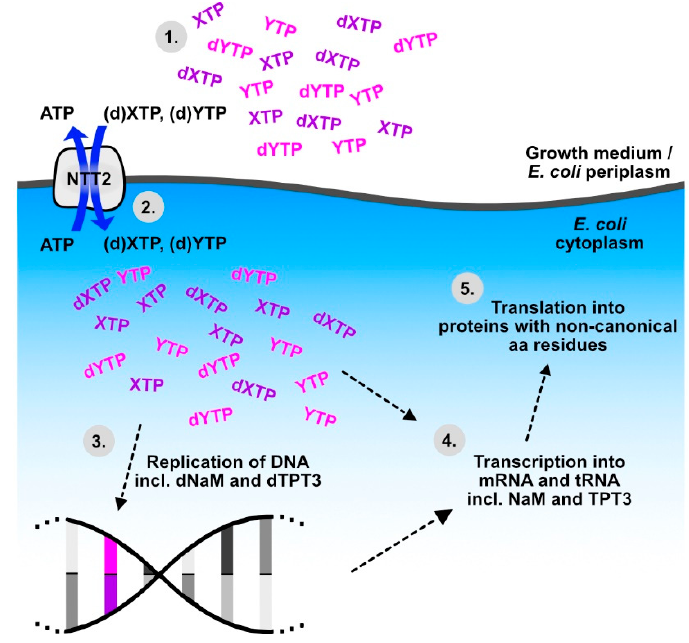
Figure 2. Pt NTT2 provides a crucial step to the workflow of expanding the genetic alphabet for the inclusion of non-canonical amino acids into proteins, as established by Zhang et al. [87]. (1) Artificial nucleotides (deoxy- and ribotriphosphates of NaM (dXTP, XTP) and TPT3 (dYTP, YTP)) are added to the surrounding medium. (2) The broad substrate specificity of Pt NTT2 allows for the uptake of (d)XTP and (d)YTP into Escherichia coli , in exchange for naturally occurring ATP. (3) DNA polymerase replicates templates that contain dNaM and dTPT3, leading to stable reproduction of the modified DNA (modified base pair in pink / purple). (4) Transcription of the modified DNA results in mRNA containing the NaM and TPT3. (5) Modified tRNAs, which fit codons with unnatural bases are transcribed and loaded with non-canonical amino acids, allowing the introduction of non-canonical residues into